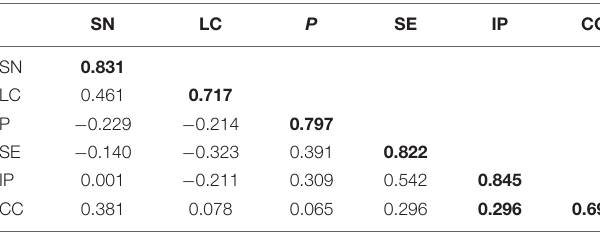
TABLE 1 | Correlations among 1 vs. with square root of